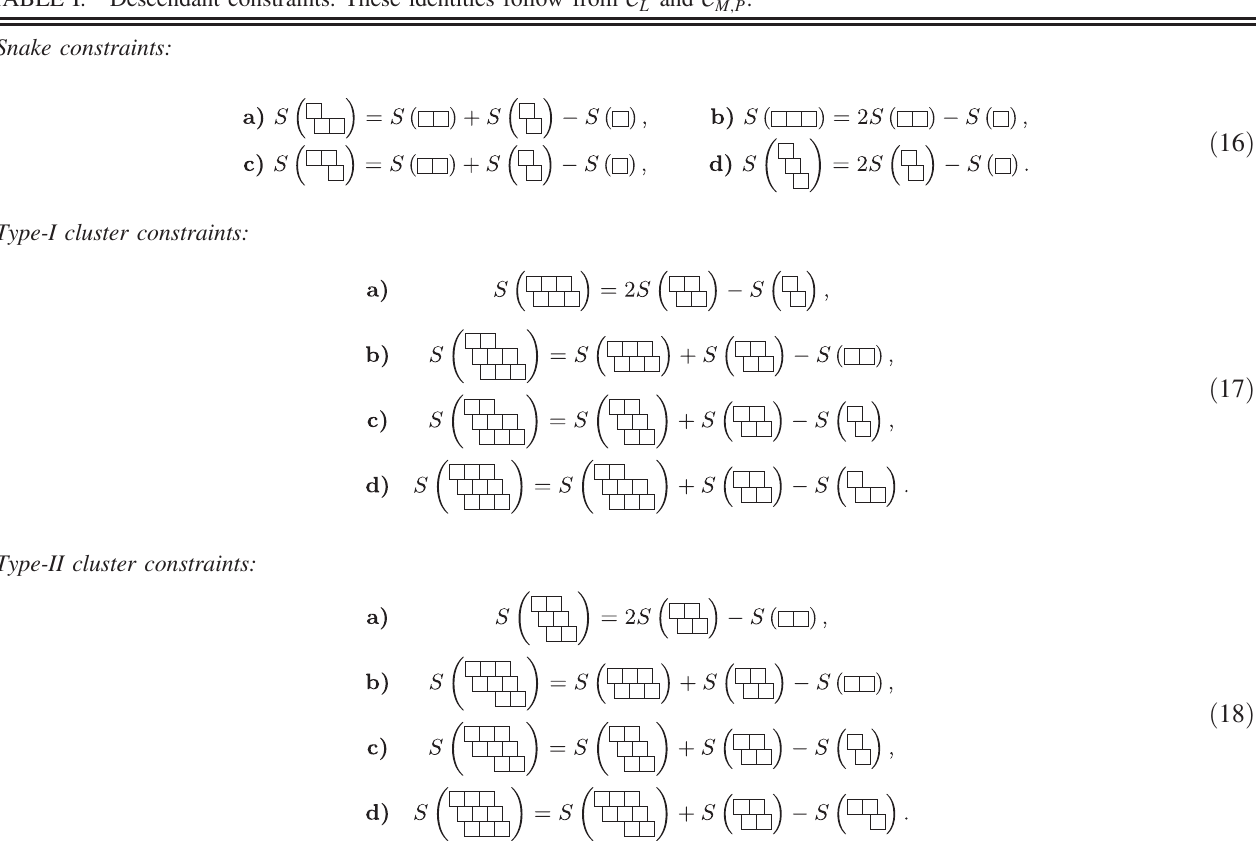
Type-I cluster constraints: